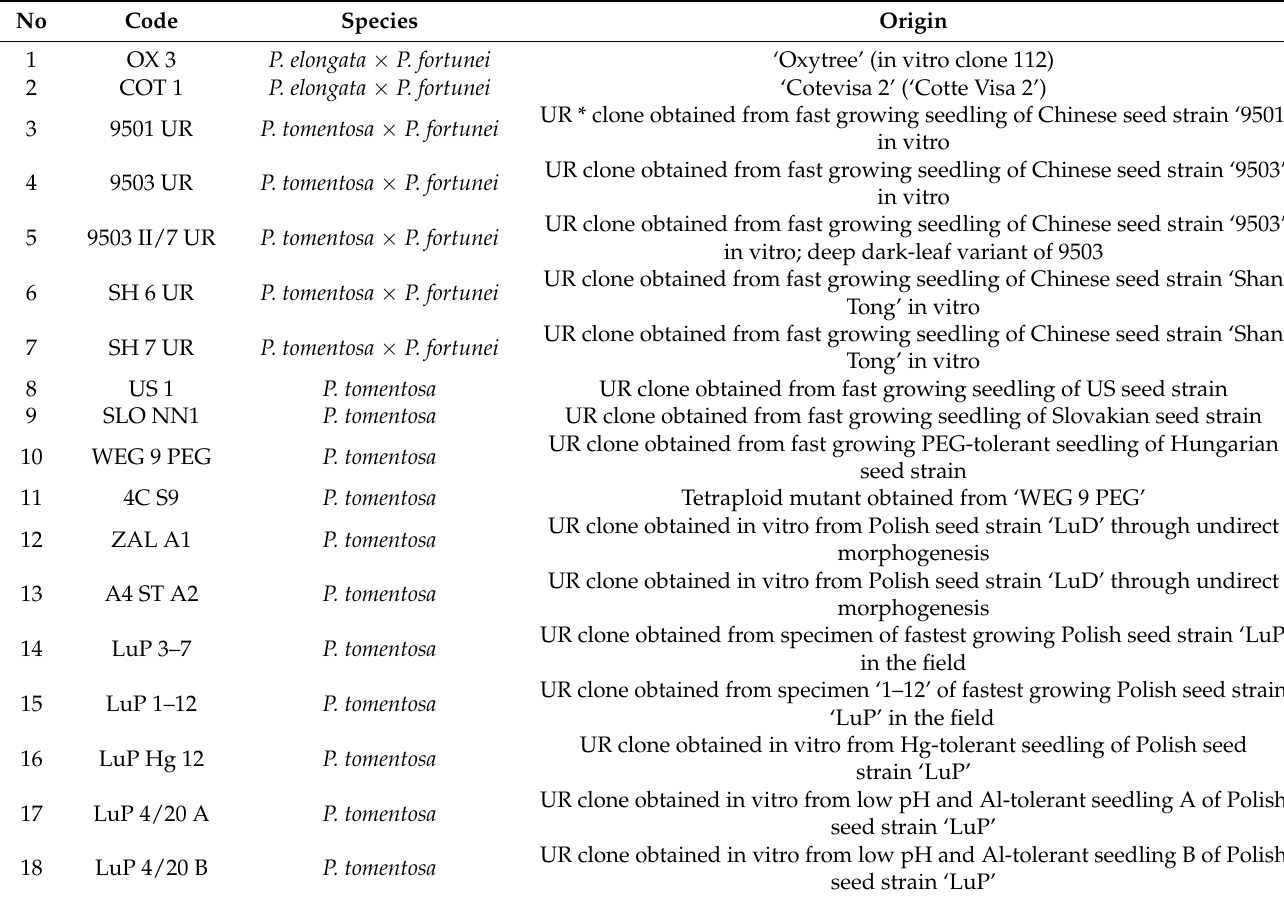
Table 1. Short description of studied paulownia